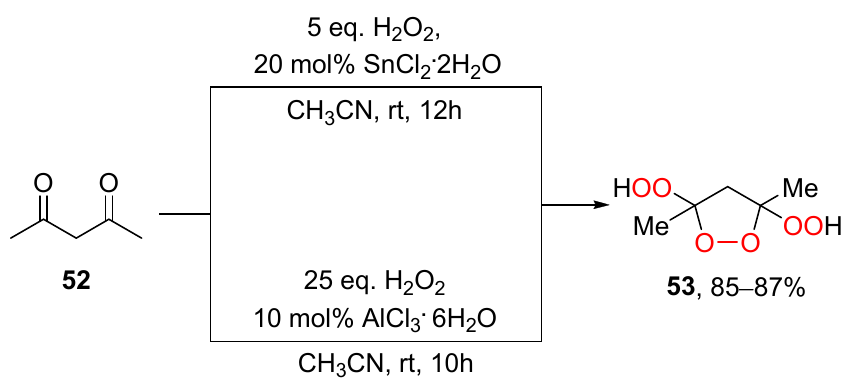
Scheme 19. Synthesis of peroxides 49–51.